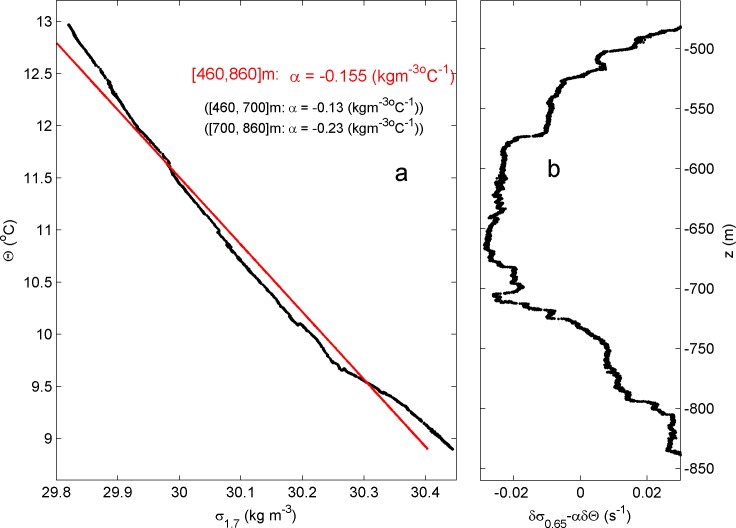
Conservative temperature-density anomaly relationship, referenced to 650 m from CTD-data obtained at 400 m from the mooring on day 186.5.(a) Potential density anomaly versus Conservative Temperature between 460 and 860 m, with two shorter ranges slopes. (b) Comparison of the slope of relationships in a. with density from profile data.